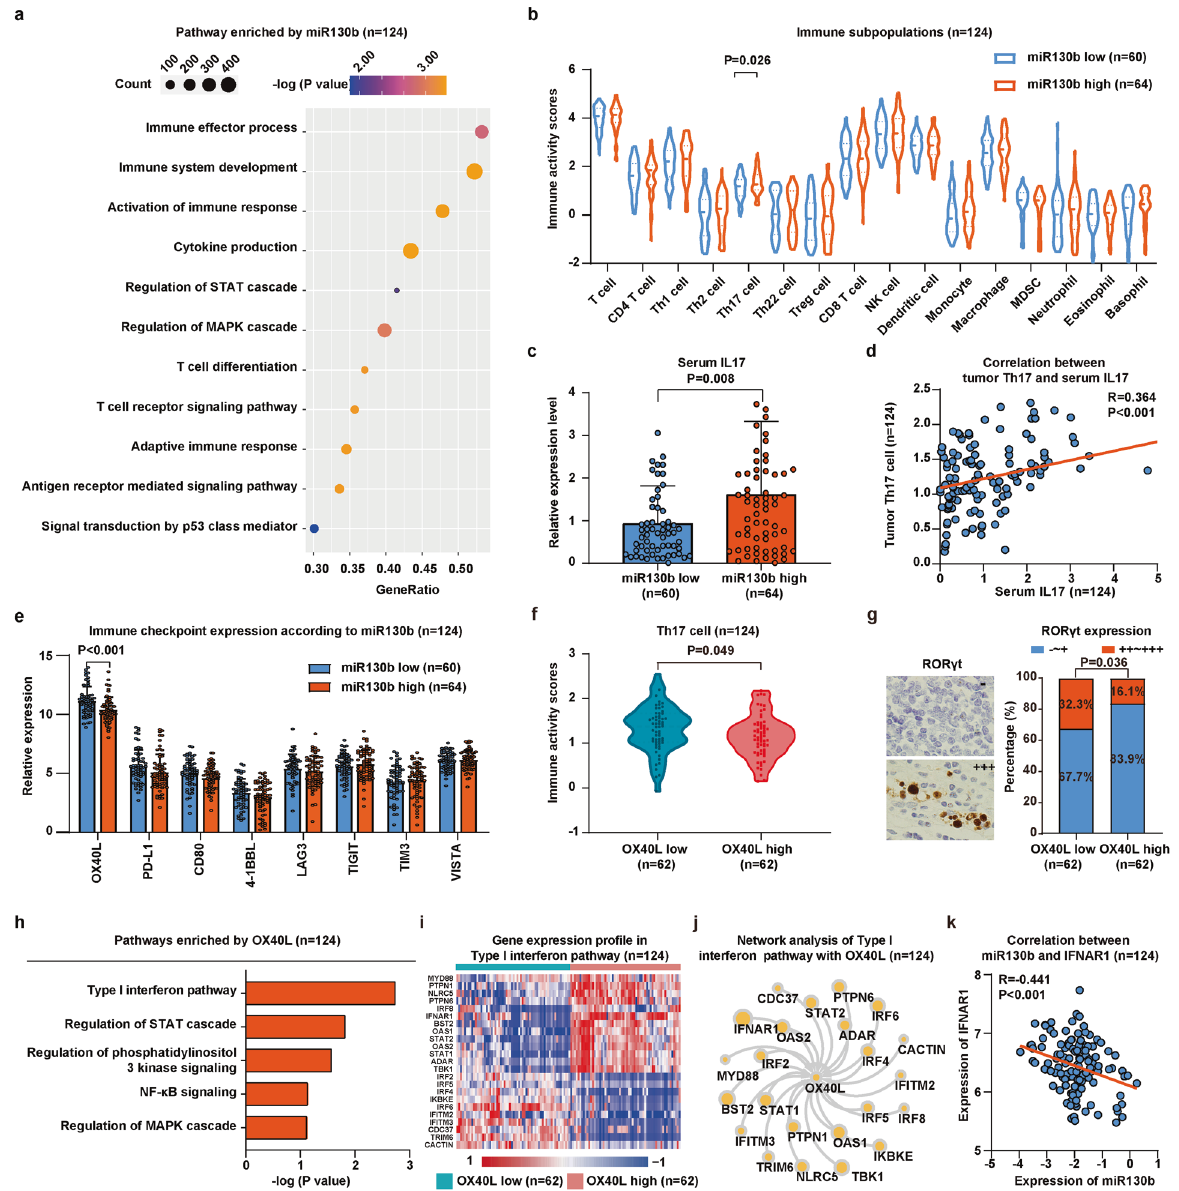
Fig. 2 MiR130b affected signaling pathways involved in the tumor microenvironment of DLBCL. a Differentially expressed gene ontology (GO) terms according to miR130b expression. − Log ( P value) of dysregulated pathways was indicated by color of points using RNA-sequencing. The size of points indicates the number of genes included in each gene set. b Distribution of immune subpopulations in miR130b high group ( n = 64) and miR130b low group ( n = 60) analyzed by transcriptomics data using TIP analysis. c Serum IL17 level of DLBCL patients measured by ELISA in miR130b high group ( n = 64) and miR130b low group ( n = 60). Data are summarized as mean ± SD. d Correlation between serum IL17 and tumor Th17 cell ( n = 124) calculated by Pearson correlation coef fi cient analysis. e Differentially expressed immune checkpoints identi fi ed by RNA-sequencing between miR130b high group ( n = 64) and miR130b low group ( n = 60). f The immune activity scores of Th17 cells of DLBCL patients in OX40L low group ( n = 62) and OX40L high group ( n = 62). g Immunohistochemical study of Th17 cells in tumor samples of DLBCL patients in OX40L low group ( n = 62) and OX40L high group ( n = 62). h Pathway enrichment analysis in DLBCL patients according to OX40L expression using gene ontology database. i Heatmap diagram of the differentially expressed gene in type I interferon pathway between OX40L low group ( n = 62) and OX40L high group ( n = 62). Mean expression values are shown. Red, increased expression; blue, decreased expression; and white, mean value. j RNA-sequencing was used to determine gene – gene interaction network of type I interferon pathway. Genes that were more likely to be functionally related were presented as larger nodes. k Correlation between miR130b and IFNAR1 expression ( n = 124) calculated by Pearson correlation coef fi cient